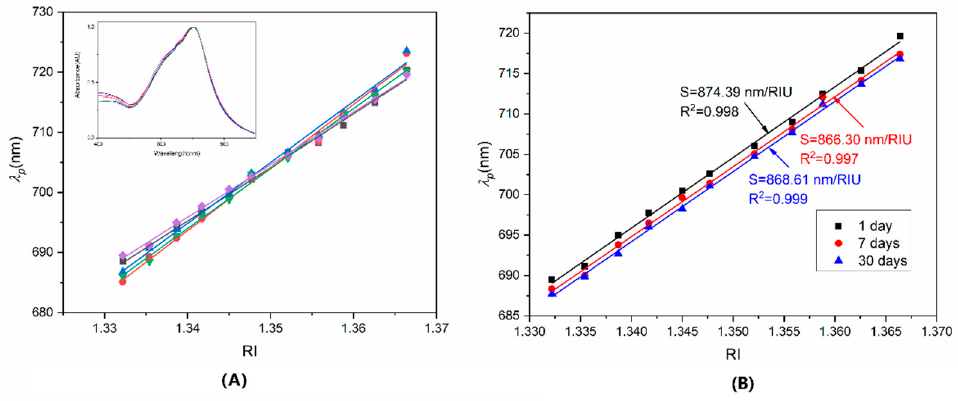
Figure 8. ( A ) S RI of five fiber sensors for consistency test, and ( B ) S RI of three test at 1 day, 7 days, and 30 days for stability evaluation.